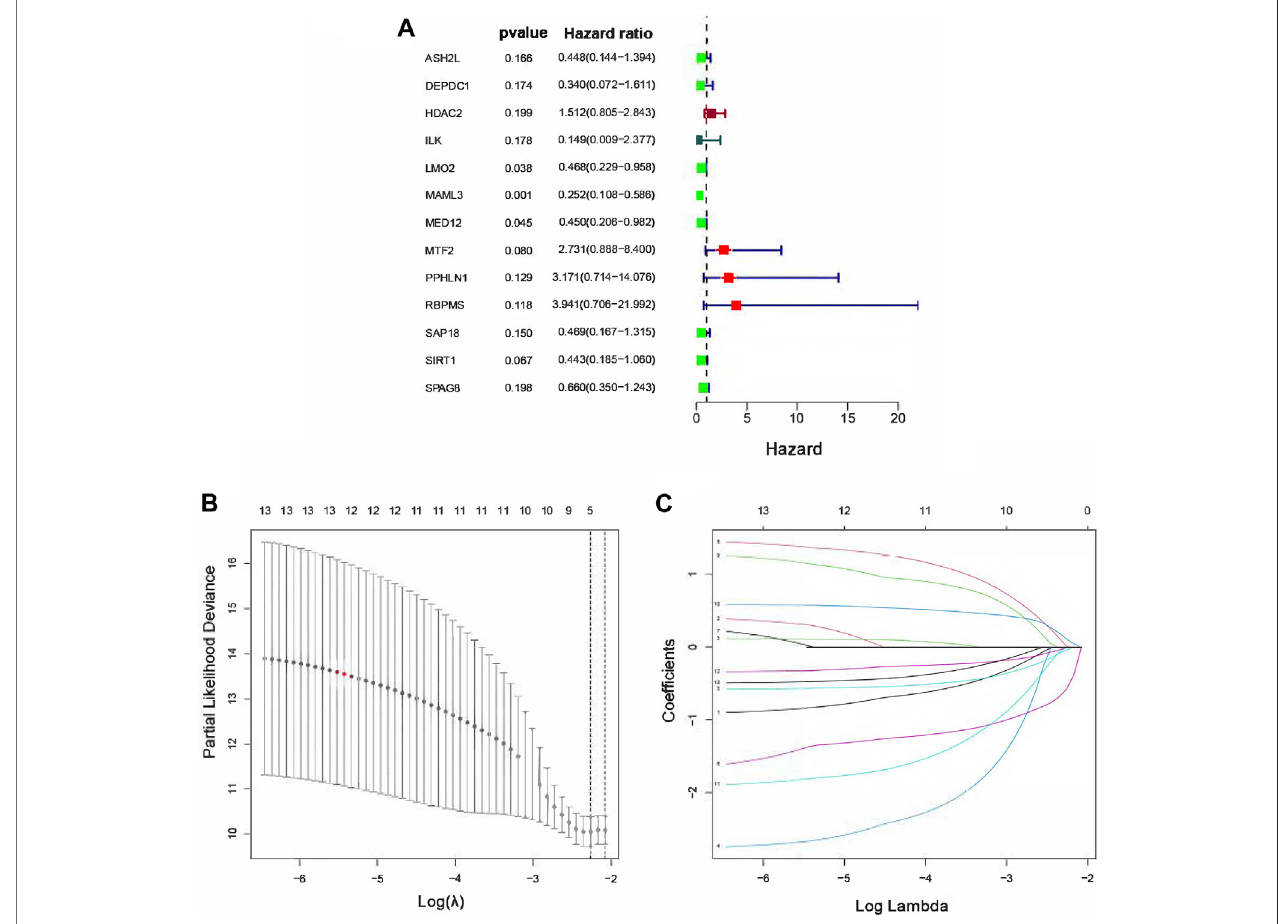
FIGURE 3 | Construction of the risk score model for osteosarcoma patients. (A) Hazard ratio of univariate Cox analysis for TcoF-related DEGs. (B) Distribution of LASSO coef fi cients for fi ve genes. (C) Coef fi cients for seven genes analyzed by LASSO. DEGs, differentially expressed genes.